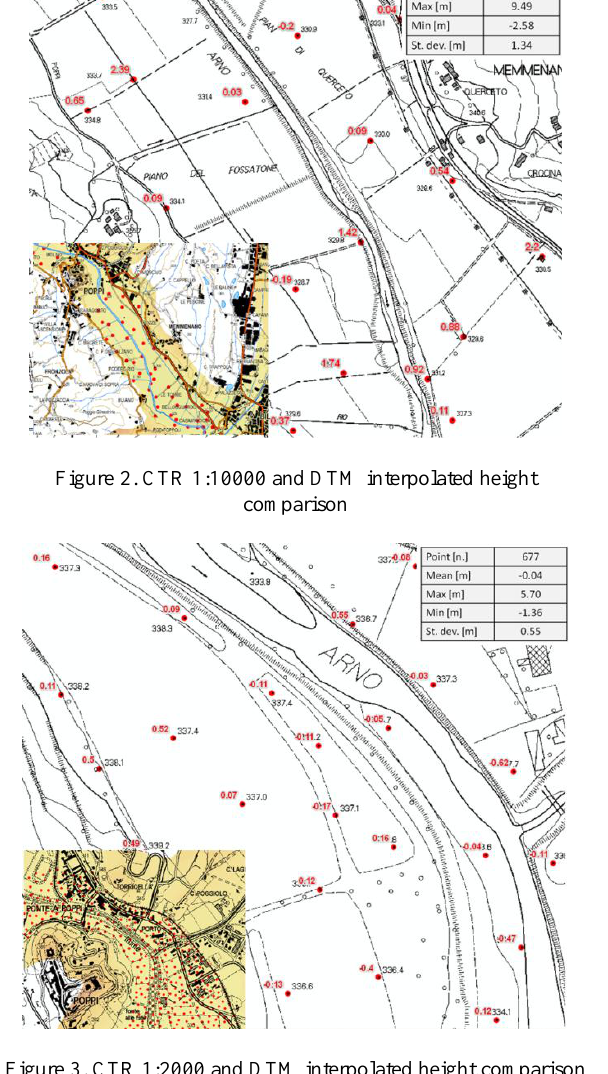
Figure 3. CTR 1:2000 and DTM interpolated height comparison